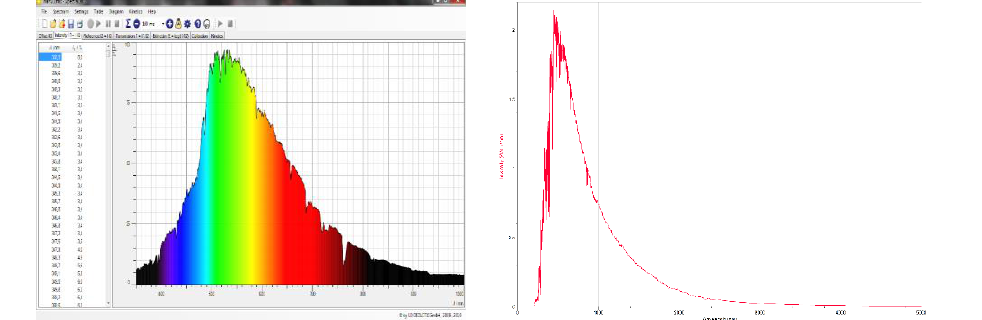
Fig. 1. Non calibrated spectrum curve of the Sun light measured from outside a window of the classroom with Leybold spectrometer and Spectralab software.